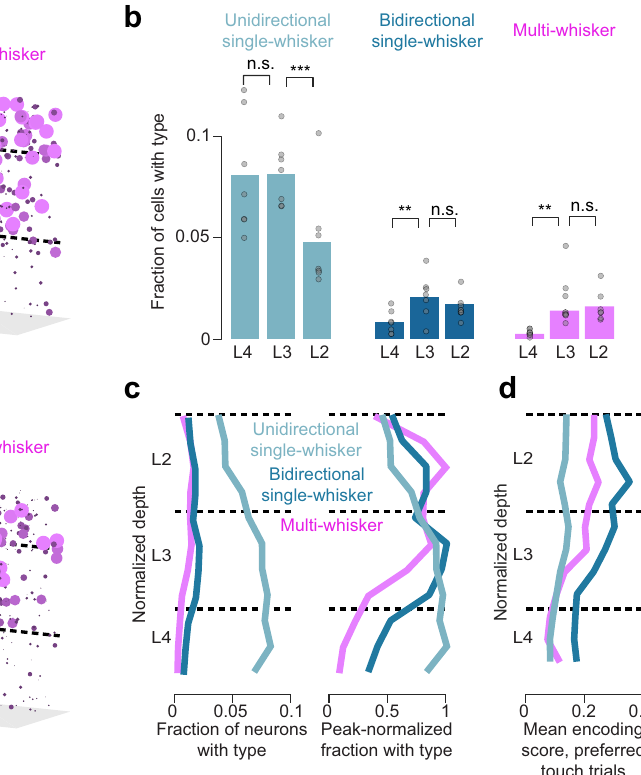
neuron types as a function of normalized depth (Methods). Left, fraction of neu- ronsatagivendepth.Right,within-typenormalizedfraction. d Encodingscoreasa function of normalized depth. Encoding score was calculated only across trials of the preferred type (i.e., trials with touches to which the neuron was signi fi cantly responsive;